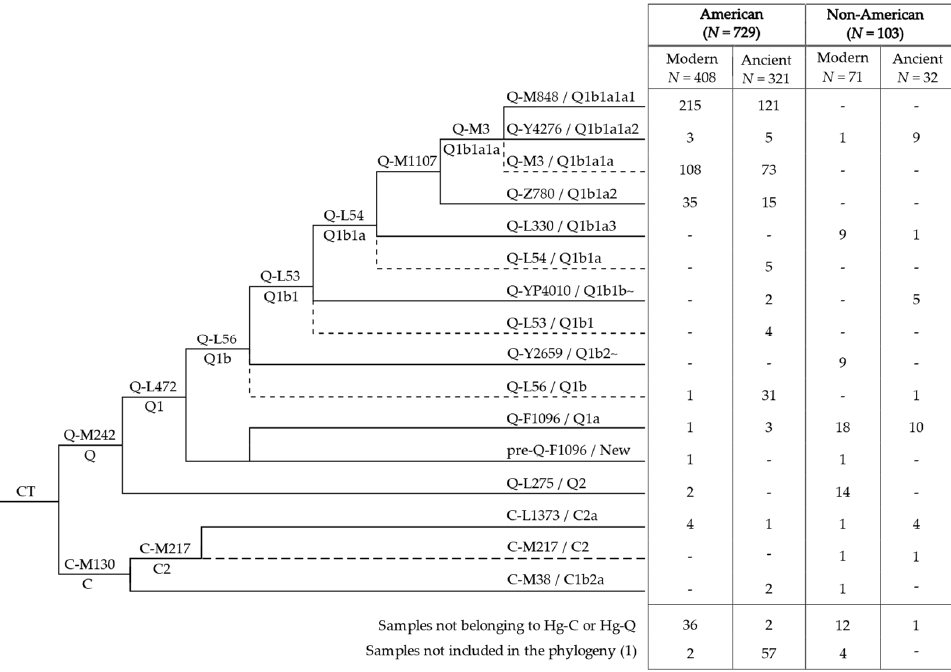
Figure 1. Structure of the main haplogroup C and Q lineages observed in our dataset. In bold are reported the absolute number ( N ) of American and non-American individuals analysed. Dashed lines harbour samples classified into the related haplogroup but not better defined (missing positions of informative downstream markers). ISOGG nomenclature (http://www.isogg.org/tree/ Date of access: 19 January 2022) is reported, when available; “New” indicate branches not reported. The table reports the absolute number of individuals ( N ) belonging to each haplogroup. (1) Samples not placed in the phylogeny due to their poor sequencing quality.